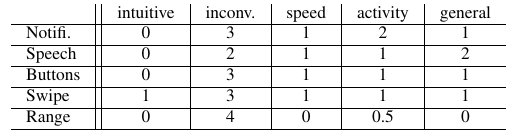
M EDIAN RATINGS FOR INTUITIVITY , INCONVENIENCE , SPEED , USABILITY DURING ACTIVITY , AND GENERAL APPLICABILITY . intuitive inconv. speed activity general Notifi.